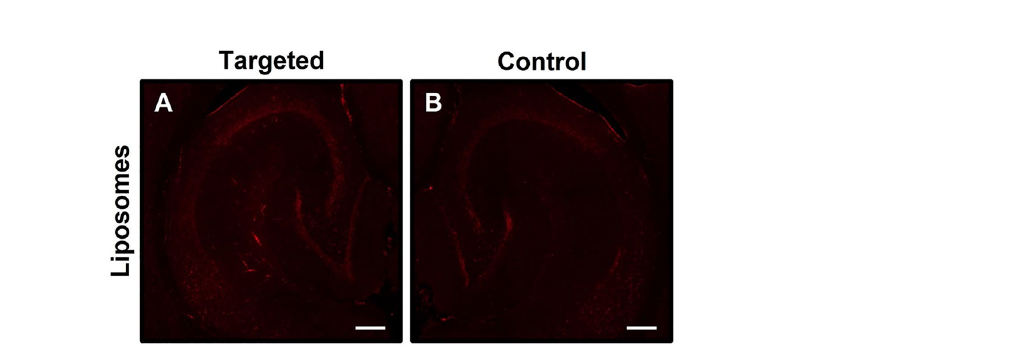
Figure 5. No delivery of DiD-PEGylated liposomes by RaSP at 0.35 MPa. Fluorescence microscopy images of horizontal mouse brain slices showed no DiD fluorescence in both ( A ) the left hippocampus region targeted with ultrasound and ( B ) the right hippocampus control region not exposed to ultrasound. A resultant NOD of 0.068 indicated no delivery of DiD-PEGylated liposomes (97.9 nm diameter) at 0.35 MPa 48 . Scale bars are 200